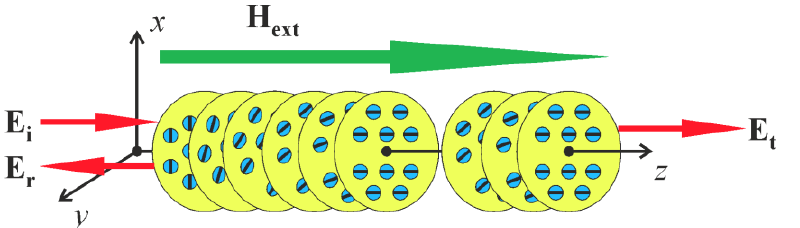
Figure 1. The geometry of the problem. The large yellow circles represent the xy cross-sections of magneto active CLC along the z -axis. They are embedded with small blue circles which are the cross-sections of the isotropic molecules without birefringence. The black lines in these circles correspond to the directions of the absorption oscillators, these directions are continuously changing forming a helicoidal structure along the z-axis.